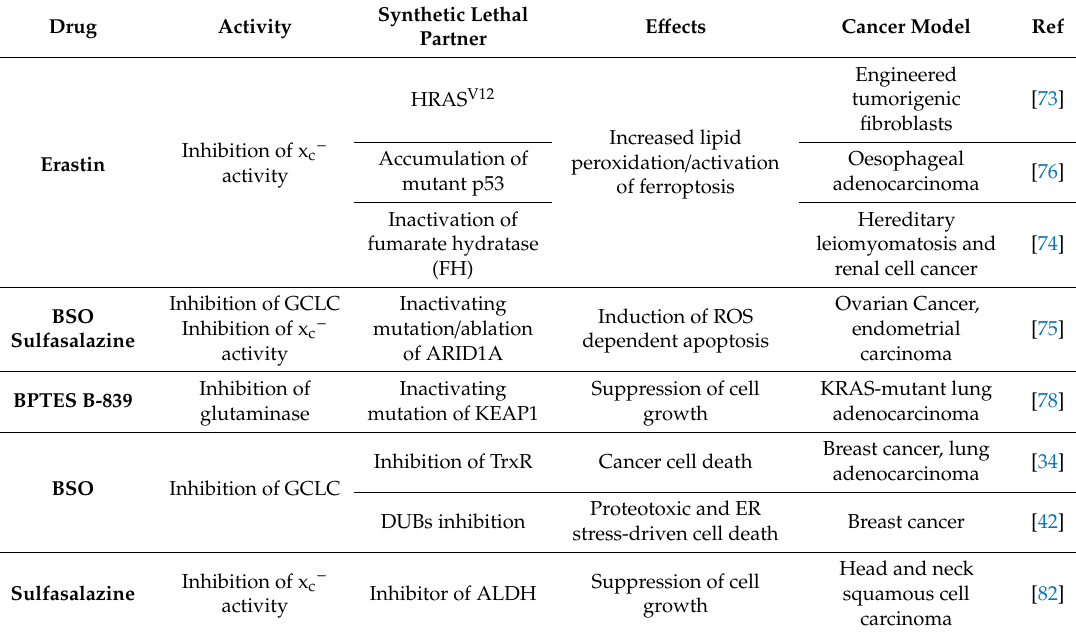
Table 1. List of synthetic lethal interactions with inhibitors of Glutathione (GSH)